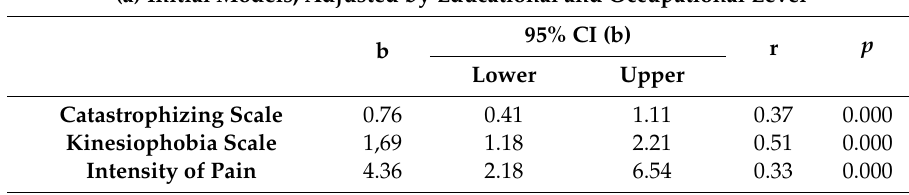
Table 5. Multivariate linear regression between reported degree of disability and kinesiophobia, intensity of pain and catastrophizing